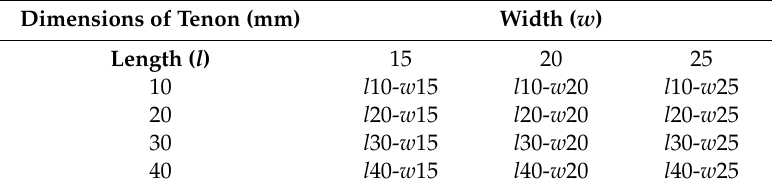
Table 2. Combinations of tenon width and tenon length evaluated in this study.